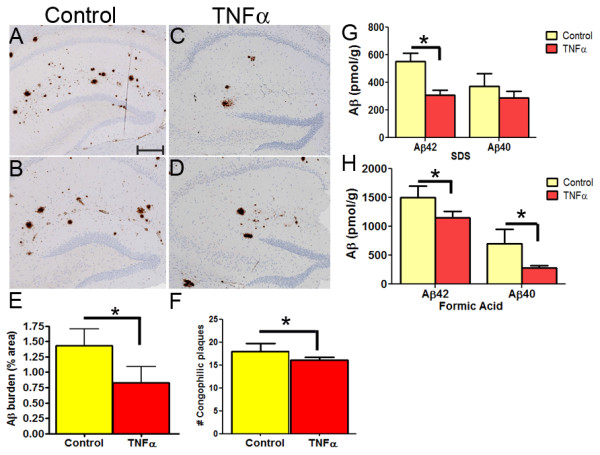
Reduction of hippocampal Aβ in AAV2/1-mTNFα expressing TgCRND8 mice. A-D. 4 month old TgCRND8 mice were stereotaxically injected in the hippocampus with either AAV2/1-mTNFα or AAV2/1-EGFP and sacrificed after 6 weeks (n = 5-6/group). Representative brain sections stained with 33.1.1 antibody (pan Aβ 1-16) depict attenuation of Aβ deposition in mTNFα expressing mice (C-D) compared to controls (A-B) in the immediate vicinity of the injection site. Scale Bar, 150 μm. E. Aβ plaque burden image analysis shows a significant decrease in amyloid deposition in mTNFα injected mice compared to control EGFP injected mice. At least three sections per sample, spaced 30 μm apart, were used for the analysis. (*p = 0.033; t test; n = 5/group). F. Quantitation of Congo Red stained compact Aβ plaques in mTNFα injected mice compared to control EGFP injected mice. Hippocampal compact plaques were counted from coronally dissected paraffin embedded representative brain sections of mTNFα and EGFP expressing mice. (*p = 0.05; t test; n = 5/group). G-H. Biochemical analyses of Aβ42 and Aβ40 levels by ELISA show significantly reduced SDS (G) and formic acid (H) extractable Aβ levels in mTNFα injected mice compared to controls (*p = 0.05; two way ANOVA; n = 4/group).